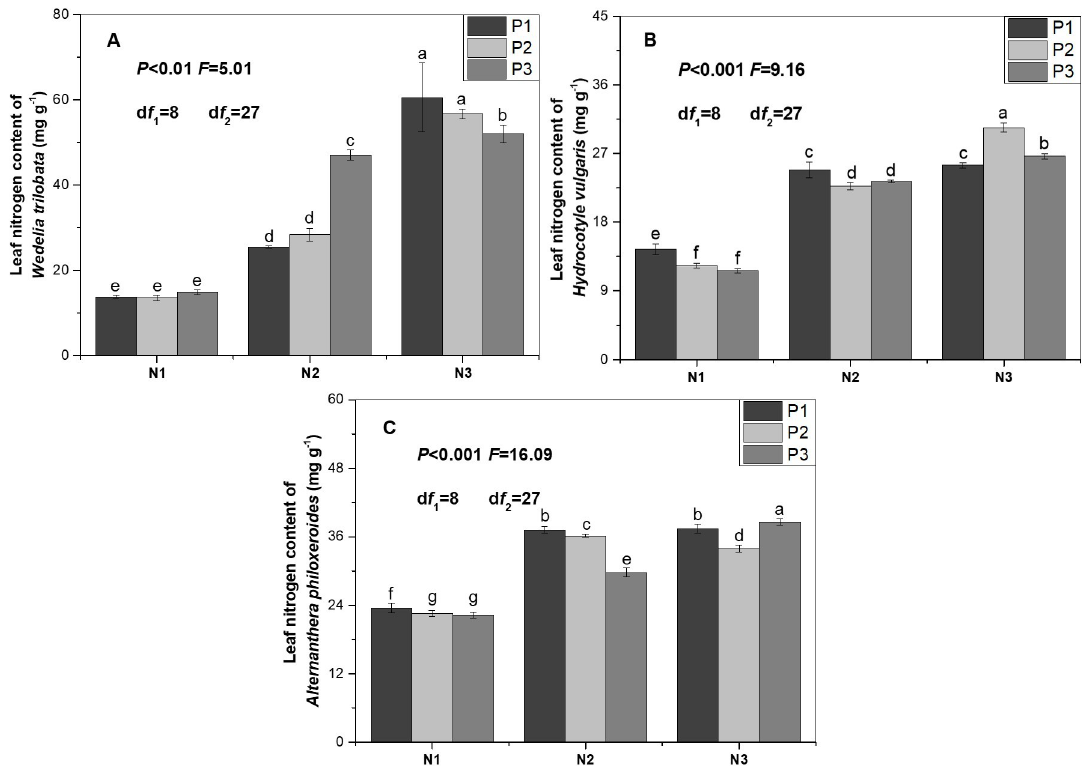
Fig 1. Nitrogen concentration in leaf of the three alien plants was subjected to different nutrient supplies. N1: Low nitrogen supply (1 mmol L -1 ); N2: Intermediate nitrogen supply (4 mmol L -1 ); N3: High nitrogen supply (8 mmol L -1 ); P1: Low phosphorus supply (0.15 mmol L -1 ); P2: Intermediate phosphorus supply (0.6 mmol L -1 ); P3: High phosphorus supply (1.2 mmol L -1 ). Values are means ± SE. Bars with different lowercase letters denote significant differences ( P <